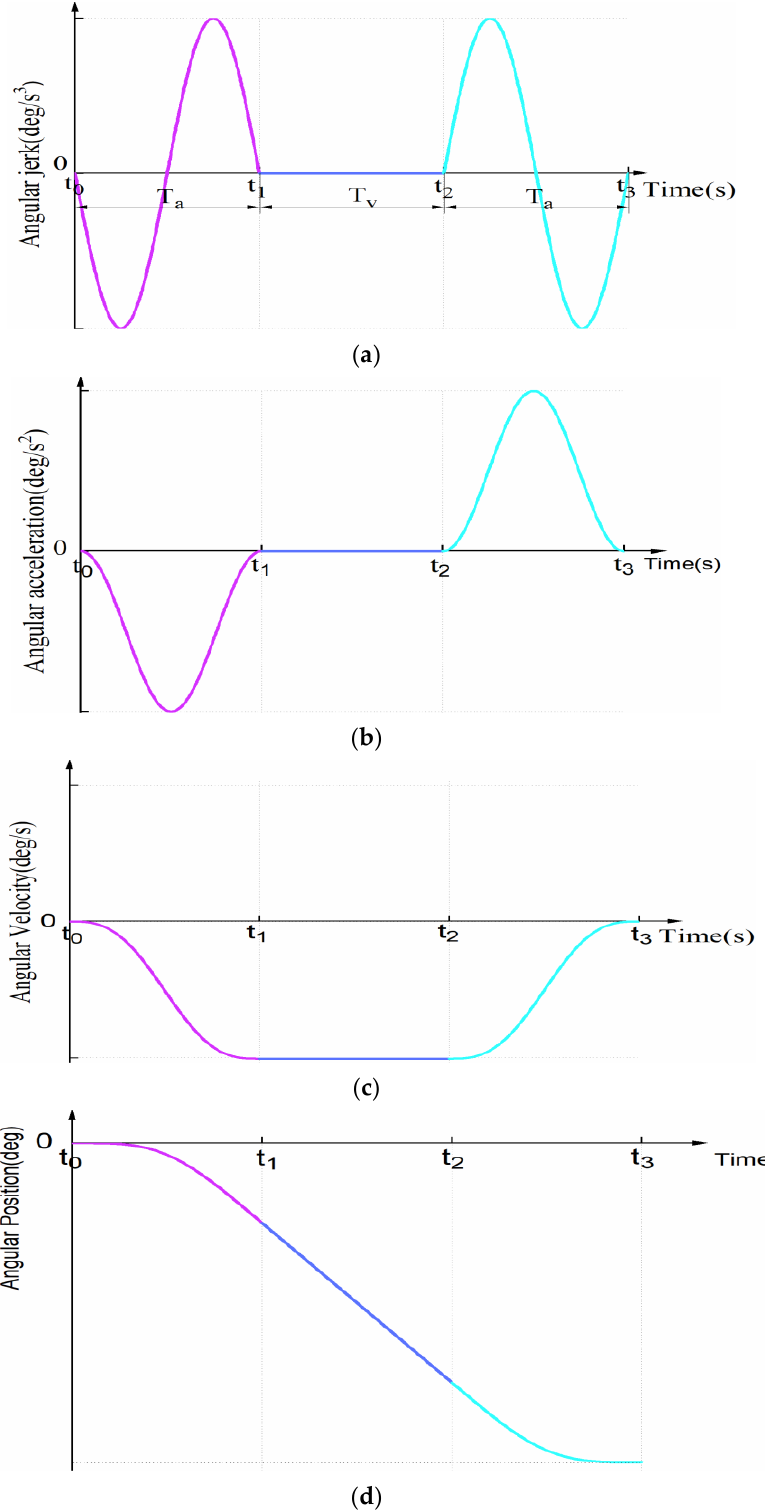
Figure 2. Three-phase sine jerk motion profile: ( a ) angular acceleration rate – time curve, ( b ) angular acceleration – time curve, ( c ) angular velocity – time curve, and ( d ) angular displacement – time curve. 𝑇 𝑎 acceleration section, 𝑇 𝑣 constant speed section, 𝑇 𝑎 deceleration section.